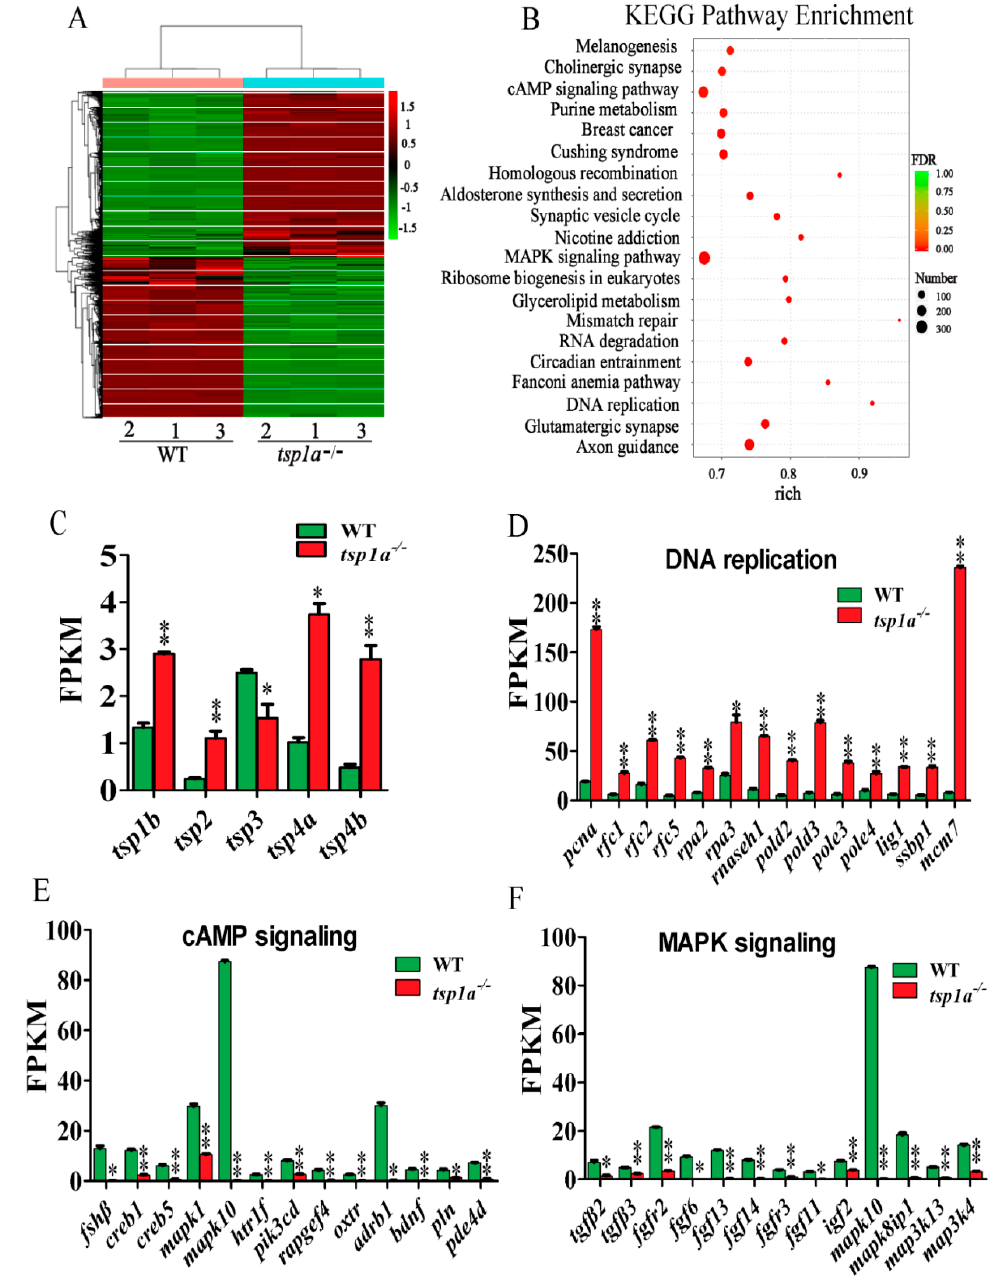
Figure 4. Comparative transcriptomic analysis of genes and molecular pathways dysregulated in tsp1a − / − ovaries. Six cDNA libraries, three for tsp1a − / − and three for WT and each with RNA for three ovaries, were constructed and sequenced. ( A ) Heat map of the expression of genes (FPKM, fragments per kilobase of exon per million fragments mapped) in tsp1a − / − and WT ovaries. ( B ) KEGG enrichment analysis of DEGs. Scatterplot of enriched KEGG pathways for DEGs screened from tsp1a − / − vs. WT fish. The enrichment factor indicates the ratio of the DEGs number to the total gene number in a certain pathway. The size and color of the dots represent the gene number and the range of false discovery rate (FDR), respectively. ( C – F ) Comparative transcriptomic analysis between tsp1a − / − and WT ovaries reveals a significant up-regulation of DNA replication-related genes and tsp family genes and significant down-regulation of cAMP and MAPK signaling pathway genes. Data were expressed as the mean ± SD of triplicates. Differences between groups were statistically examined with two-tailed unpaired Student’s t-test; * p < 0.05, ** p < 0.01.